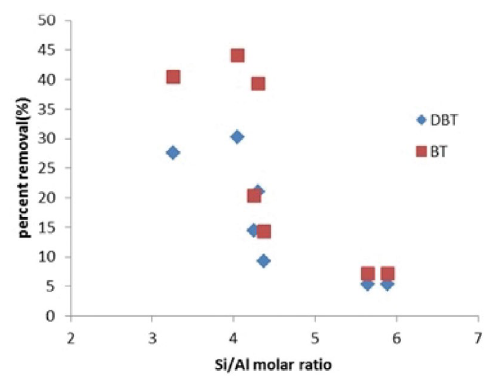
Fig. 7. The extent of sulfur removal as a function of Si/Al ratio for BT and DBT sulfur compounds